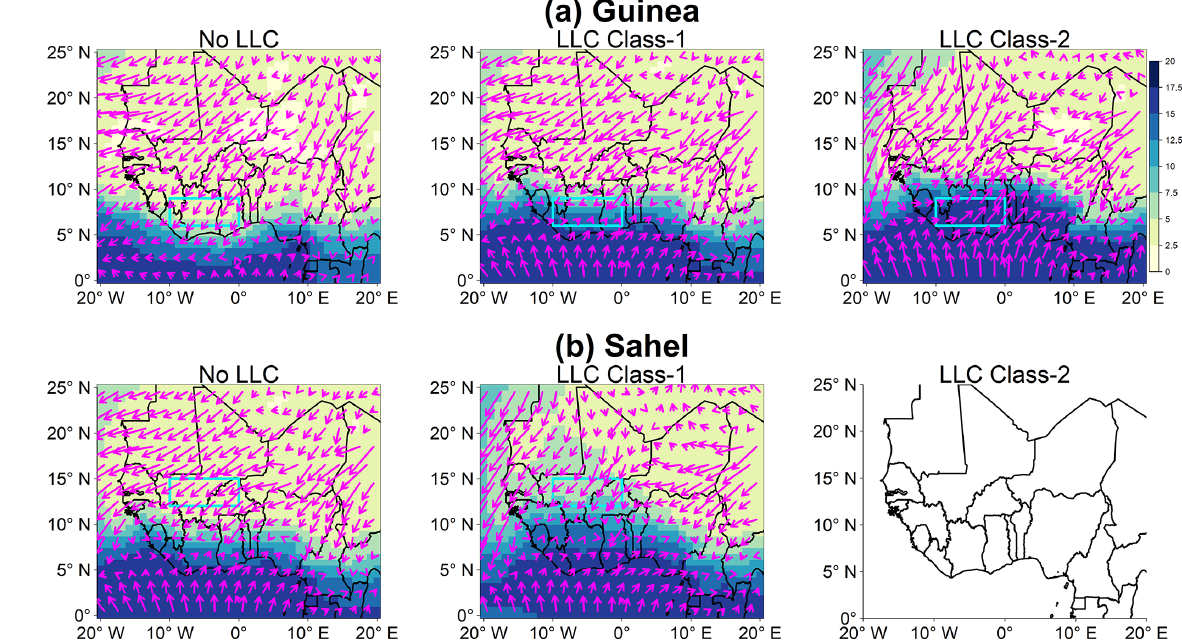
Figure B1. Composites of 950hPa specific humidity (colors, gkg − 1 ) and wind (vectors, ms − 1 ) over WA for the three LLC occurrence classes in the Guinea (a) and Sahel (b) windows during DJF from 2006 to 2015. Only occurrences that last for at least 6 consecutive hours are considered. Wind vectors are averaged over two grid points in both the x and y directions. No event of LLC Class-2 has been extracted in the Sahel area during DJF, hence the empty